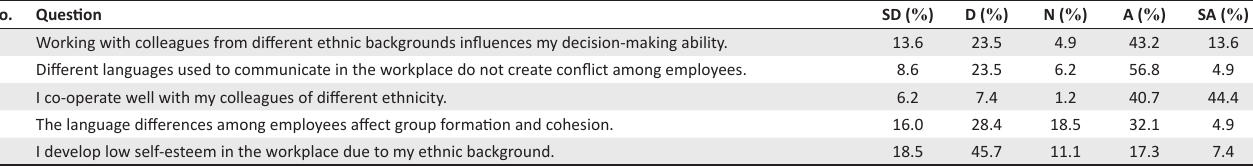
TABLE 5: Central tendencies measurement: Ethnic diversity.